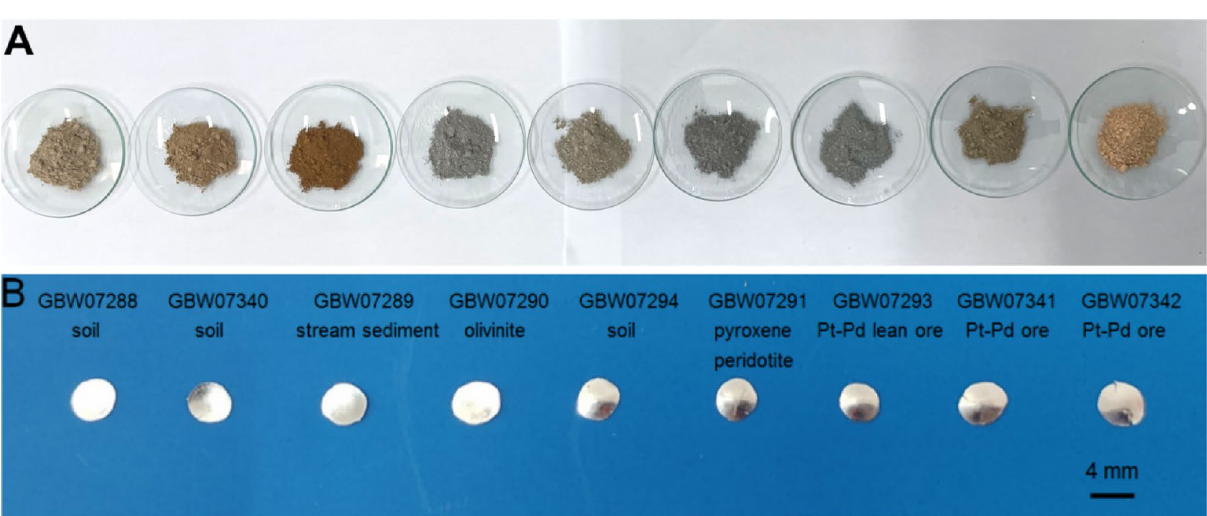
Figure 3. The typical Ag slices of CRMs. ( A ) CRMs before Bi-FA, ( B ) CRMs after